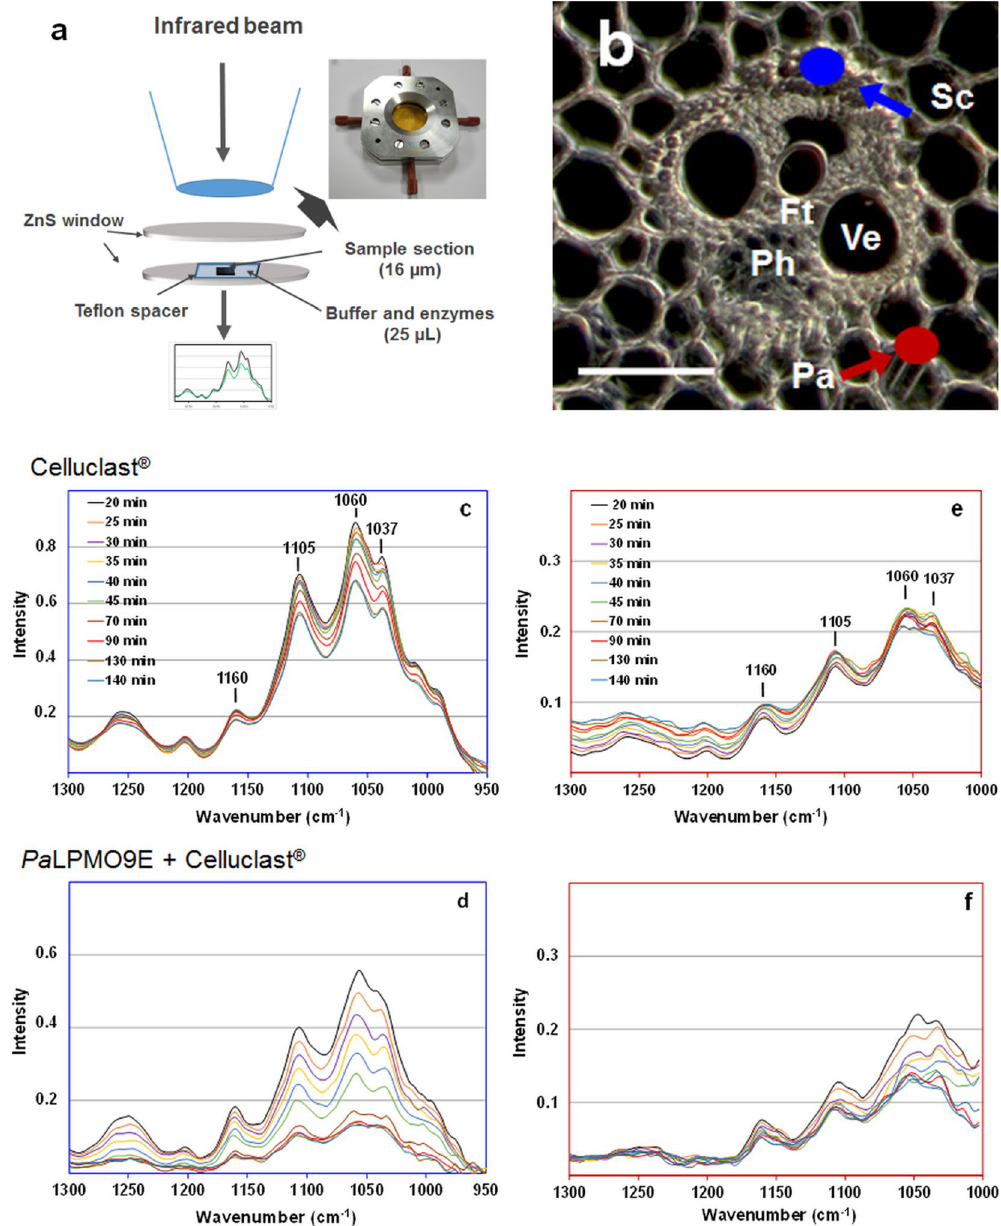
Figure 4. Real time monitoring of FTIR spectra of chlorite-treated miscanthus during enzymatic conversion. ( a ) Experimental setup using the microfluidic device. ( b ) Vascular bundles cells and localization of sclerenchyma (Sc) and parenchyma (Pa) (scale bar is 50 µ m). Evolution of sclerenchyma FTIR spectra during hydrolysis ( c ) by Celluclast ® alone or ( d ) with Pa LPMO9E. Evolution of parenchyma FTIR spectra during hydrolysis ( e ) by Celluclast ® alone or ( f ) with Pa LPMO9E. Scale bar is 100 µ